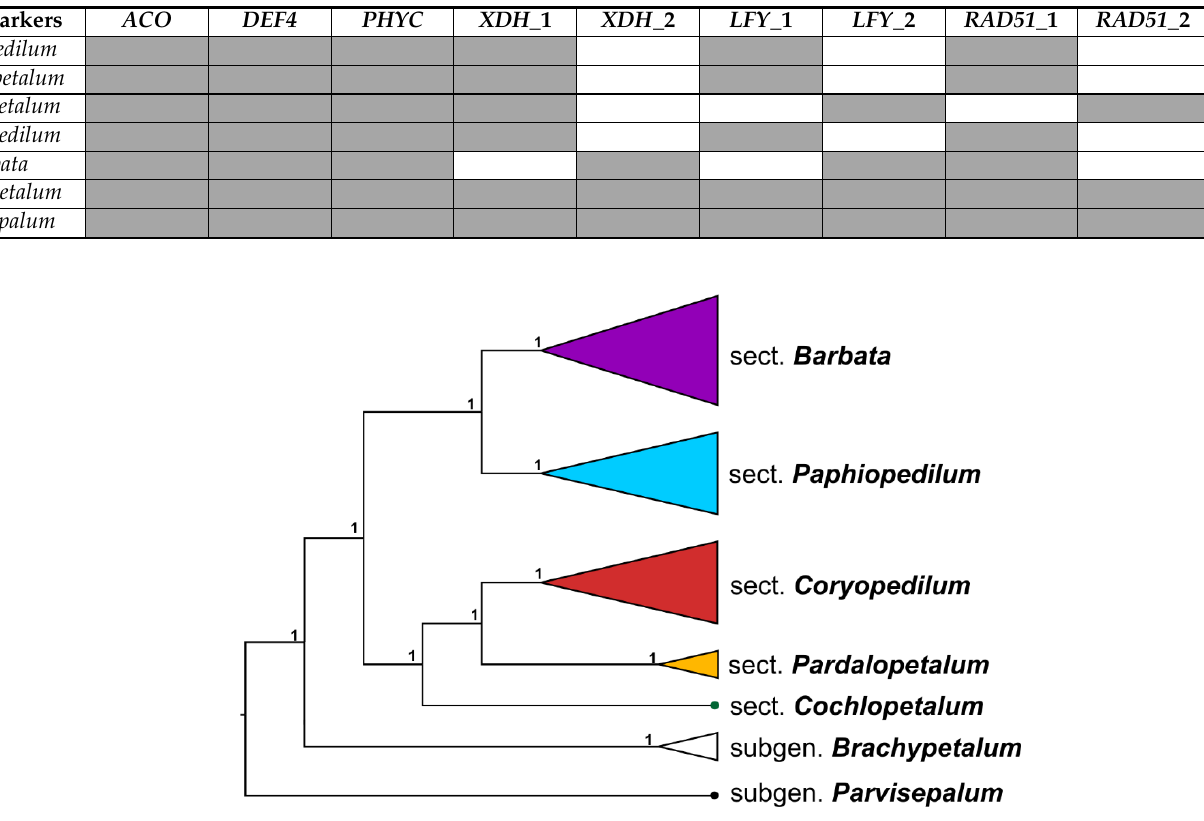
Figure 2. Nuclear gene tree of Paphiopedilum genus based on combined analysis of